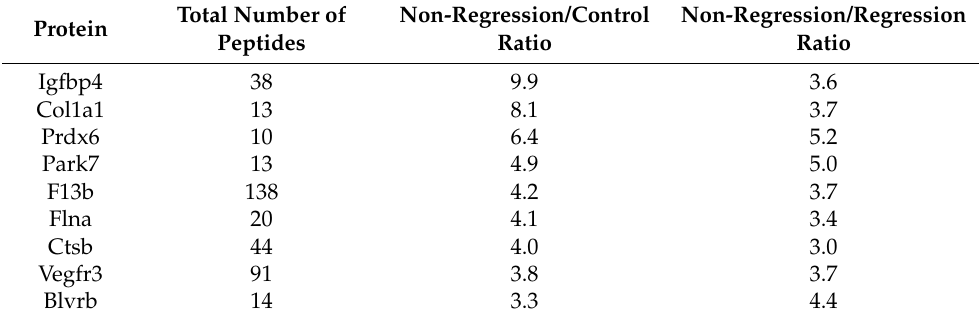
Table 1. Plasma proteins increased in Non-regression iKAP mice.